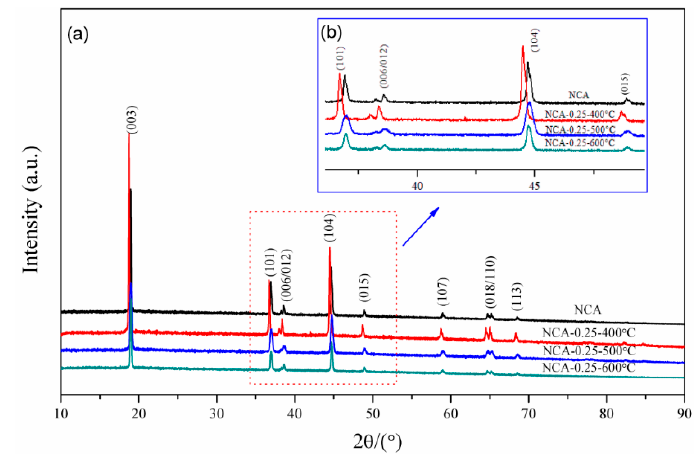
Figure 3. ( a ) XRD patterns of the pristine NCA sample and NCA-0.25 samples at different calcination temperature from 400 °C to 600 °C, and ( b ) the magnified patterns of ( a ) between 33° and 50°.